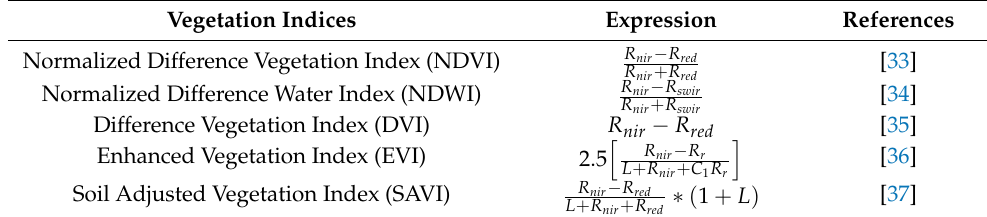
Table 2. Vegetation indices extracted from Sentinel-2 satellite imagery. Vegetation